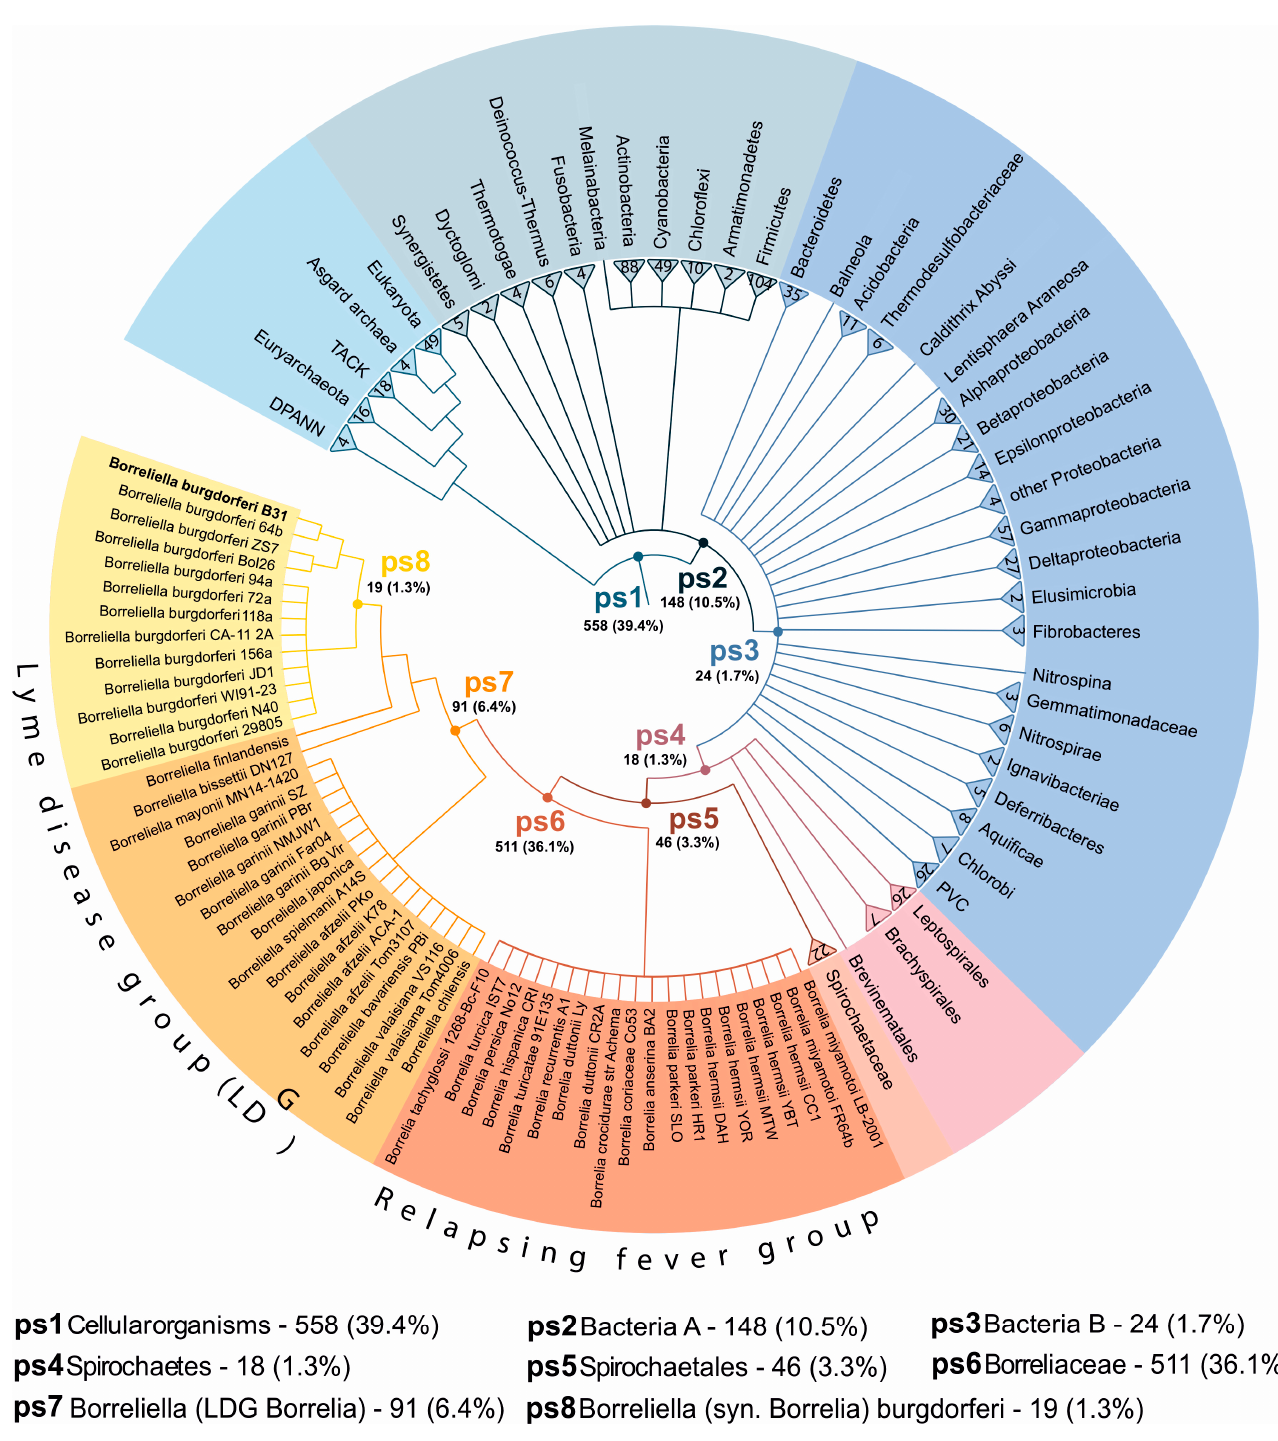
Figure 5. The consensus phylogeny used in the phylostratigraphic analysis. The consensus tree covers divergence from the last common ancestor of cellular organisms to B. burgdorferi as a focal species (see File S9 for a fully resolved tree). The tree is constructed by considering the importance of evolutionary transitions, availability of reference genomes, and their completeness estimated using BUSCO scores. The eight internodes (phylostrata) that lead from the root of the tree to the focal species ( B. burgdorferi B31) are marked by ps1–ps8. Numbers at the top of terminal nodes represent the number of species in the fully resolved tree and correspond to the genomes used to populate the reference database for sequence similarity searches. The number of B. burgdorferi genes traced to each phylostratum, and a corresponding percentage, is written following the phylostratum name.